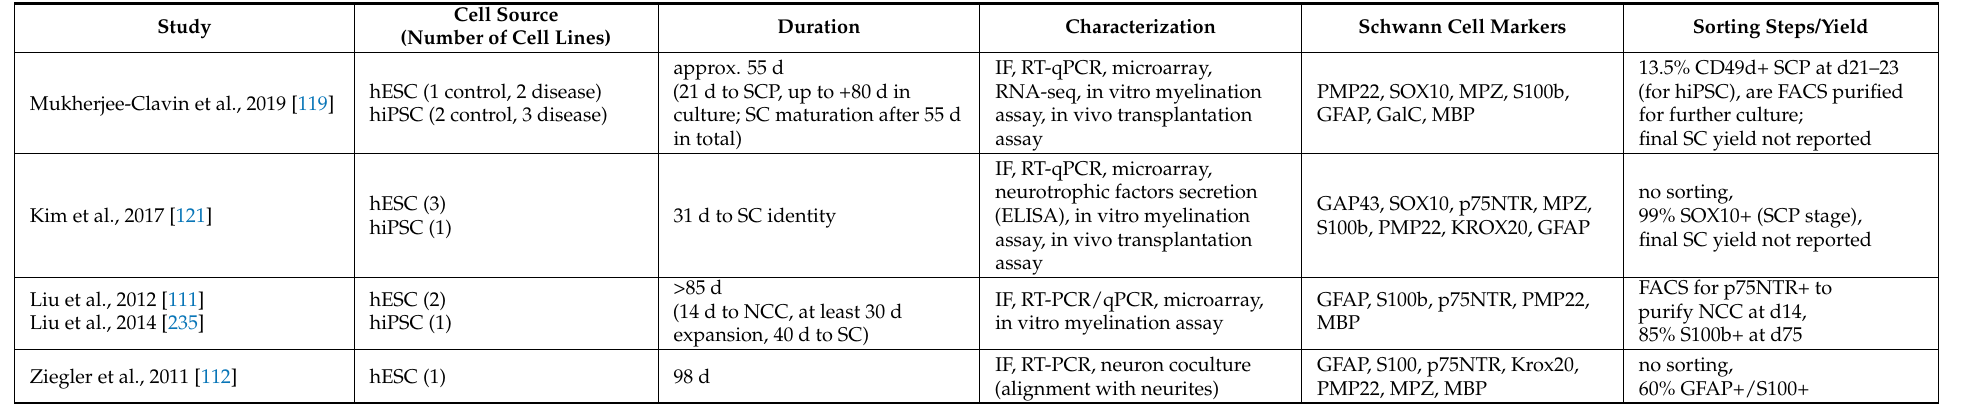
Table 1. Studies describing primary protocols for Schwann cell differentiation from hiPSC and/or hESC. Sorted from the most to least recent.